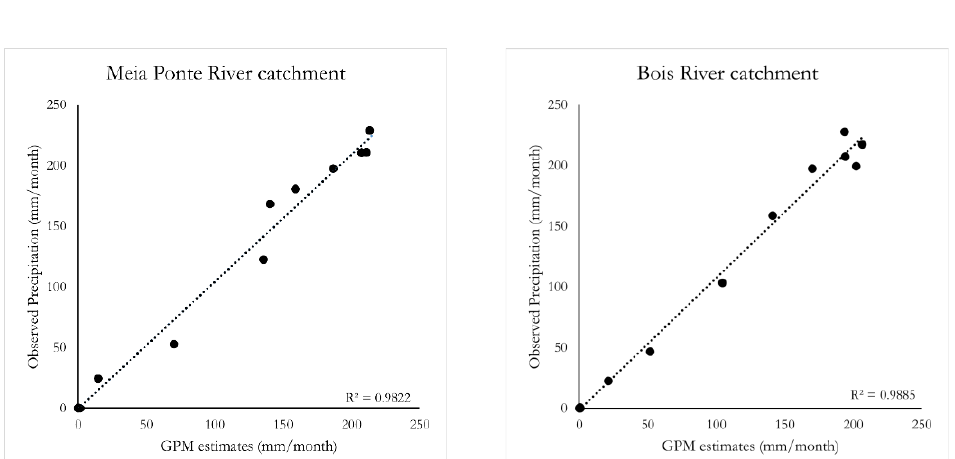
Figure 7. Scatterplots of monthly rainfall amounts for the GPM retrievals and ground-based gauges in the Meia Ponte ( left panel) and the Bois River catchments ( right panel).